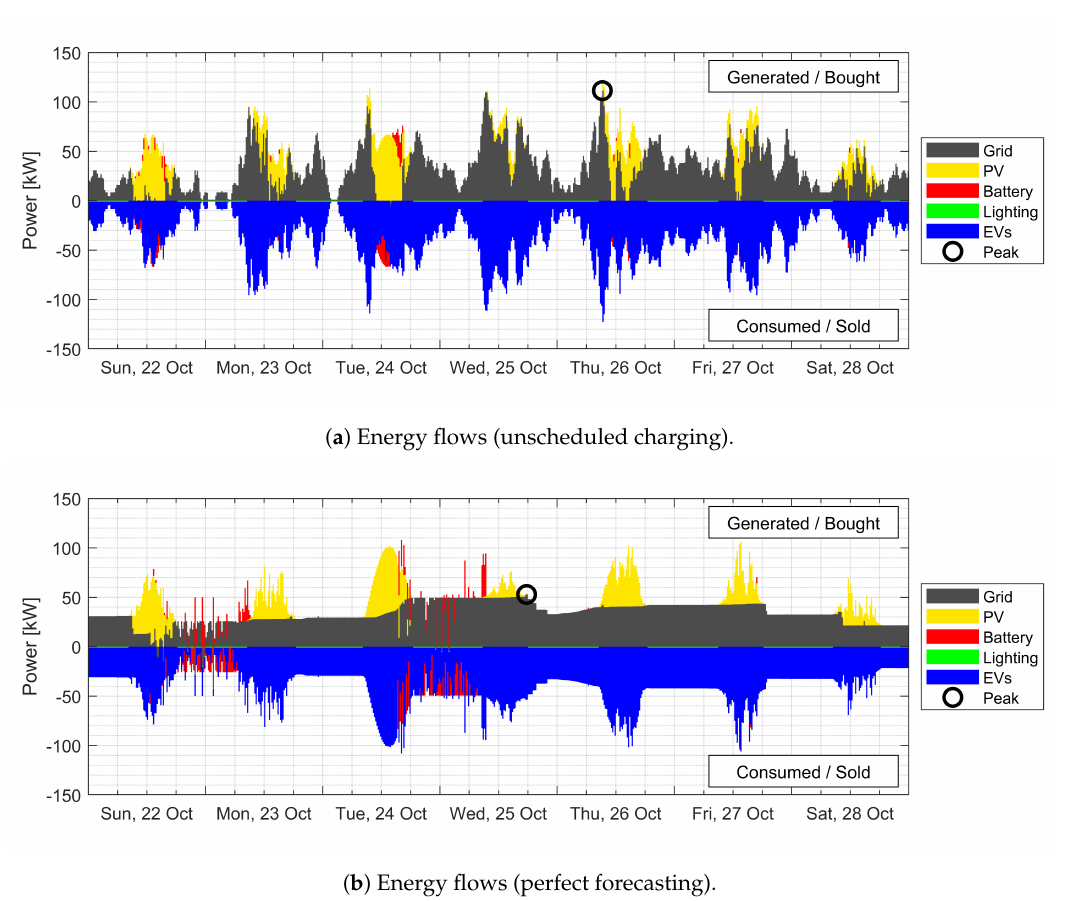
Figure 3. Comparison of energy flows in the solar parking lot with unscheduled charging as opposed to charging with perfect